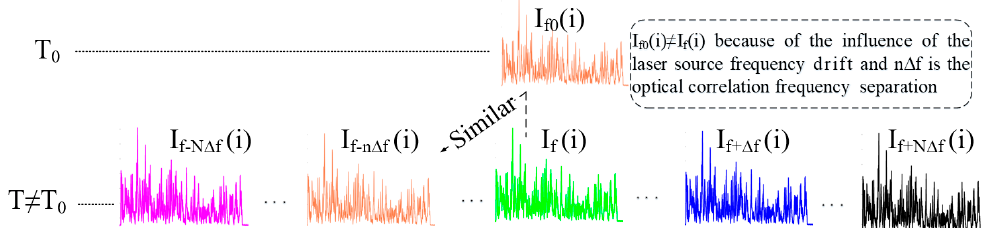
Figure 2. Principle of the active compensation of the laser output frequency drift using the wavelength diversity technique. N and ∆ f are respectively the operating sweep number and frequency sweep step of the tunable laser, n is the number corresponding to the OTDR trace best correlated to the previous.